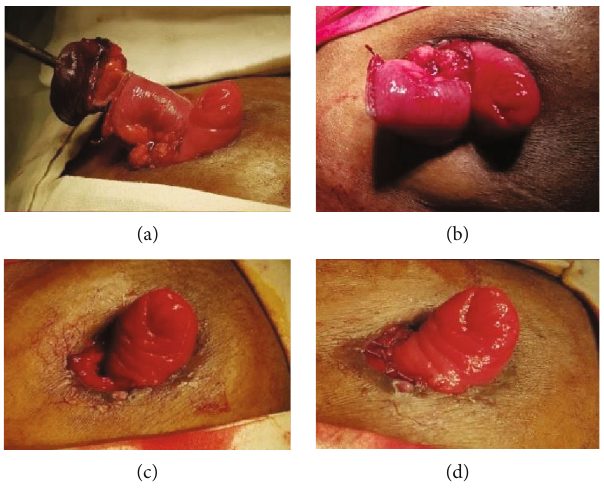
Figure 2: (a), (b) Prolapse distal limb stapled. (c) Distal limb reduced into the abdomen. (d) Corrected stoma